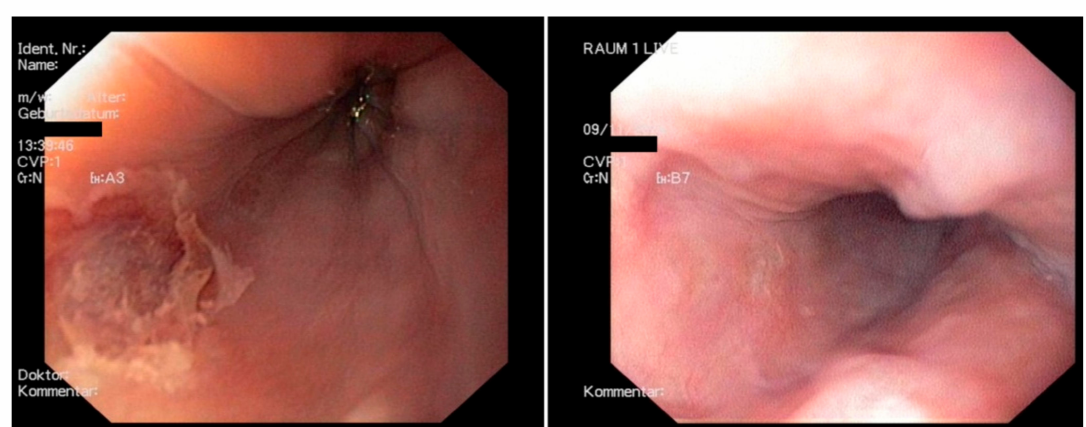
Figure 4. Representative image of an endoscopically detected esophageal lesion (EDEL) early and five weeks after contact force RF-PVI. Left: Endoscopy documents a superficial mucosal ulceration early after ablation, 40 × 20 mm at 30 cm from the incisors (Kansas City classification type 2a), which was asymptomatic to the patient. Right: Healing with residual scarring 5 weeks after ablation.